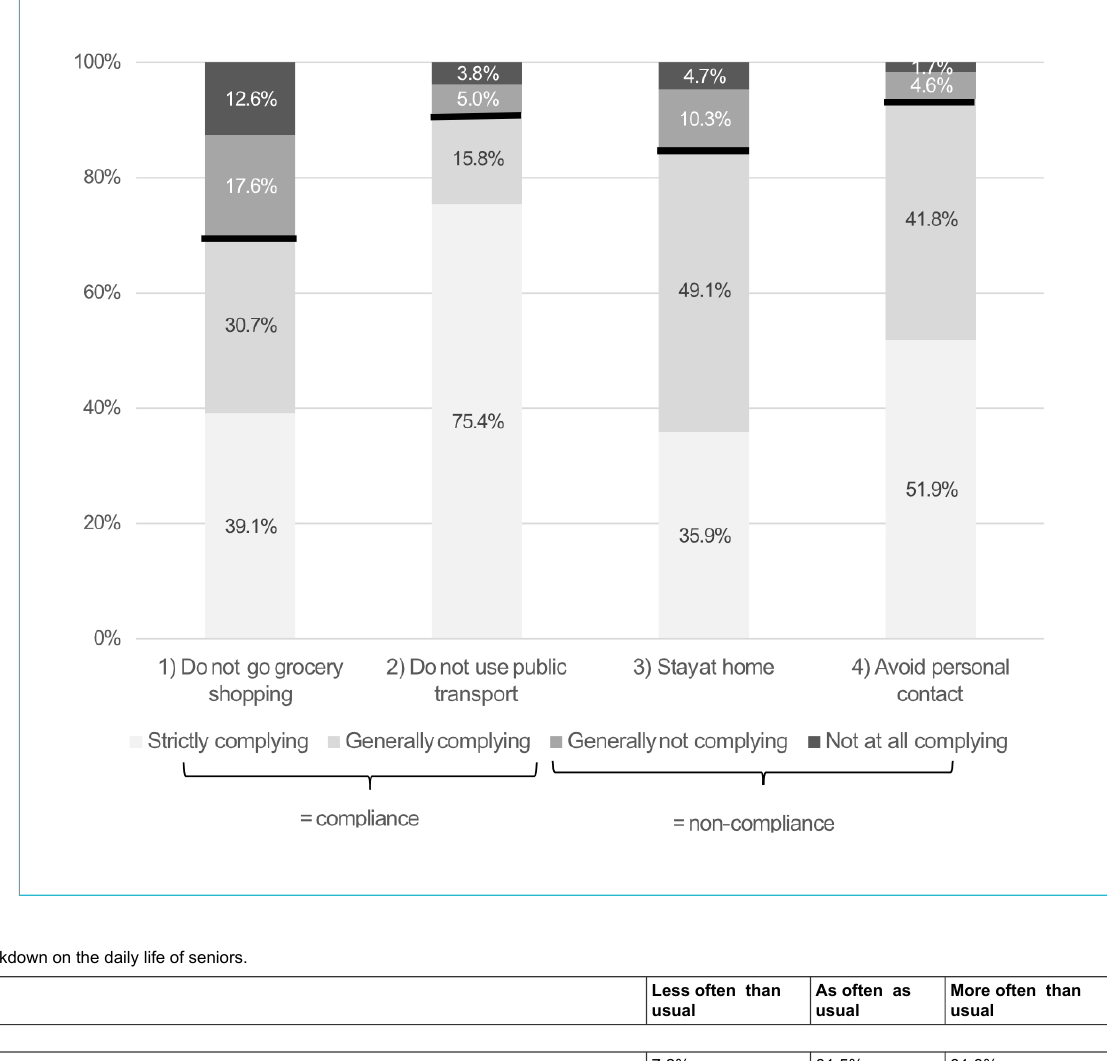
Figure 2: Compliance with the recommendations.